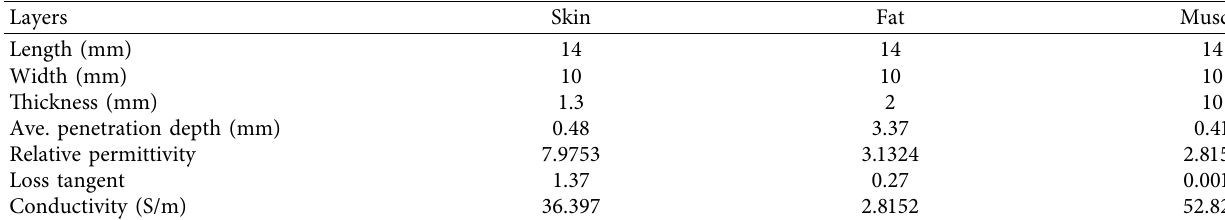
Table 3: Modeled human body layer parameters and